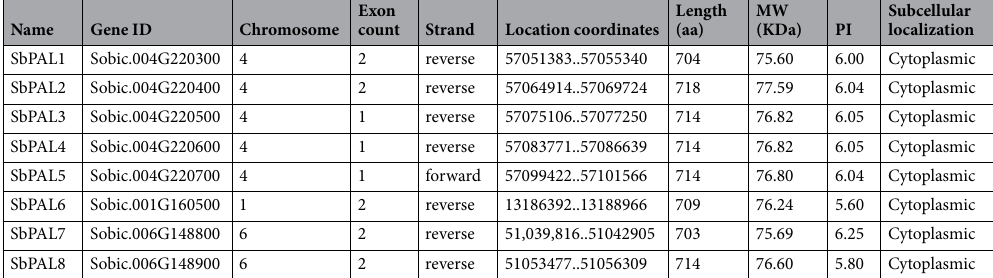
Table 1. The general information, structural features and properties of PAL genes of